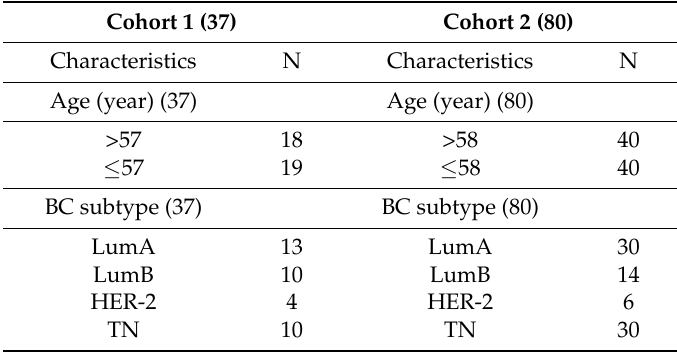
Table 1. Clinical information regarding the patients included in the